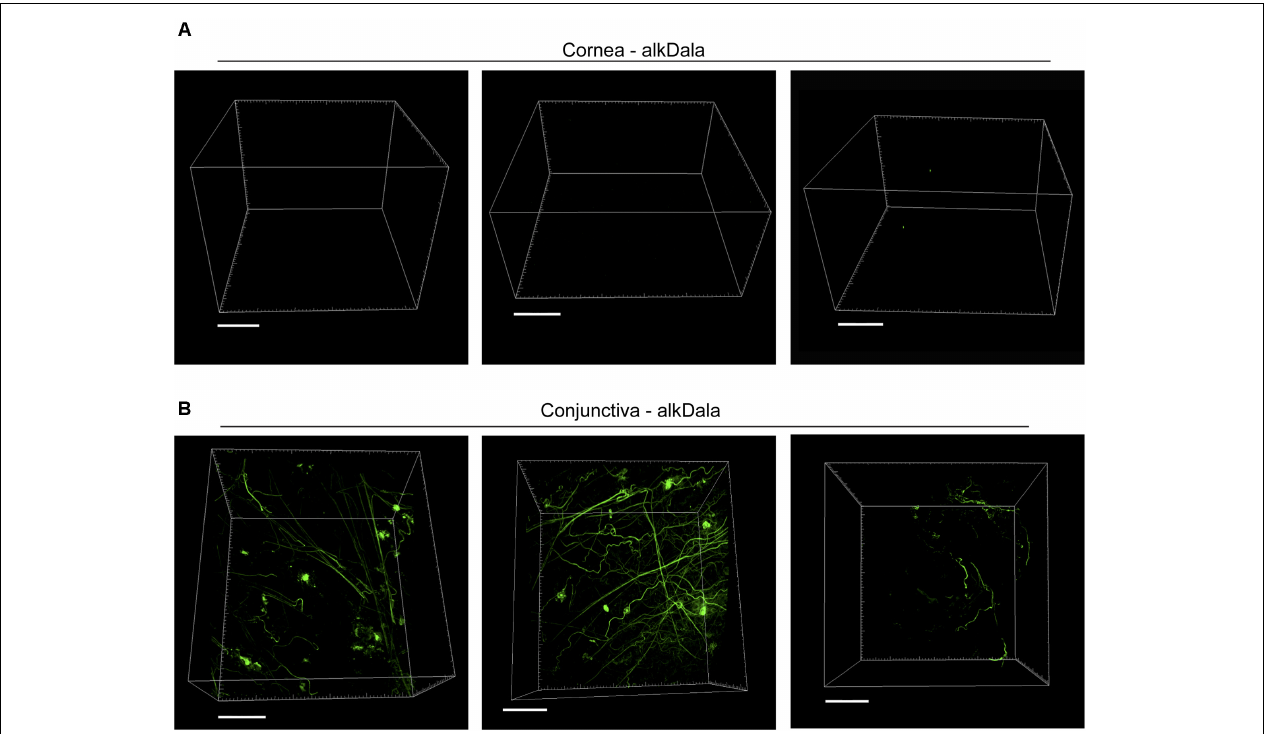
FIGURE 2 | The healthy murine cornea is nearly devoid of viable bacteria. (A) AlkDala labeling revealed very few viable bacteria on the healthy corneas of C57BL/6 mice. Representative fields shown from four different labeled corneas (two male and two female mice). (B) AlkDala labeling of the conjunctiva of C57BL/6 mice revealed numerous viable bacteria, many in a filamentous form. Representative fields of view are shown from seven different eyes (three male and four female mice). Scale bars, 50 µ m.